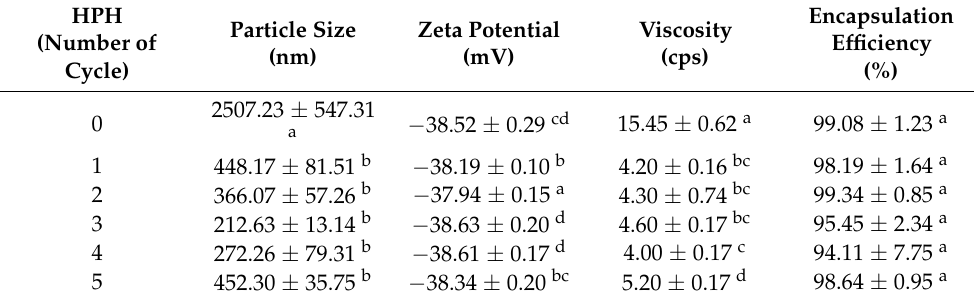
Table 1. The physical characteristic of pterostilbene nanoemulsion with or without high-pressure homogenization